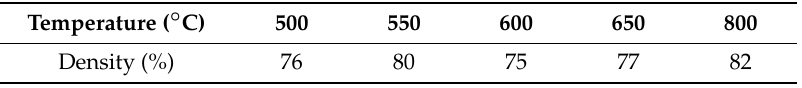
Table 9. Evolution of pellet density relative to sintering temperature.